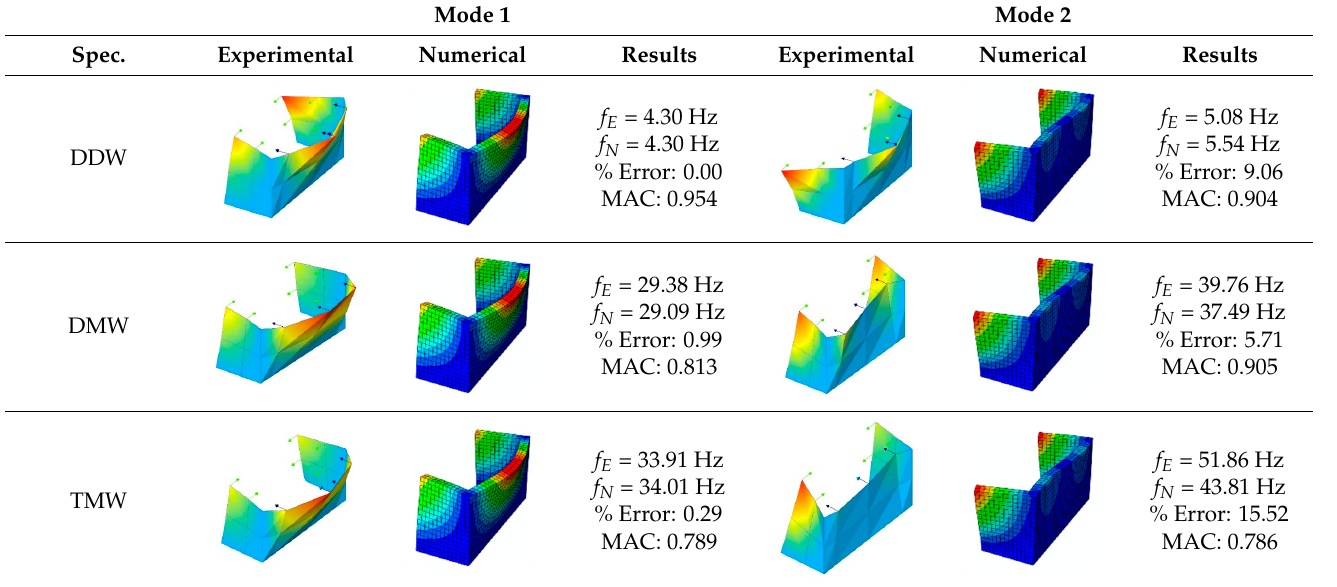
Table 2. Comparison of experimental and numerical mode shapes.